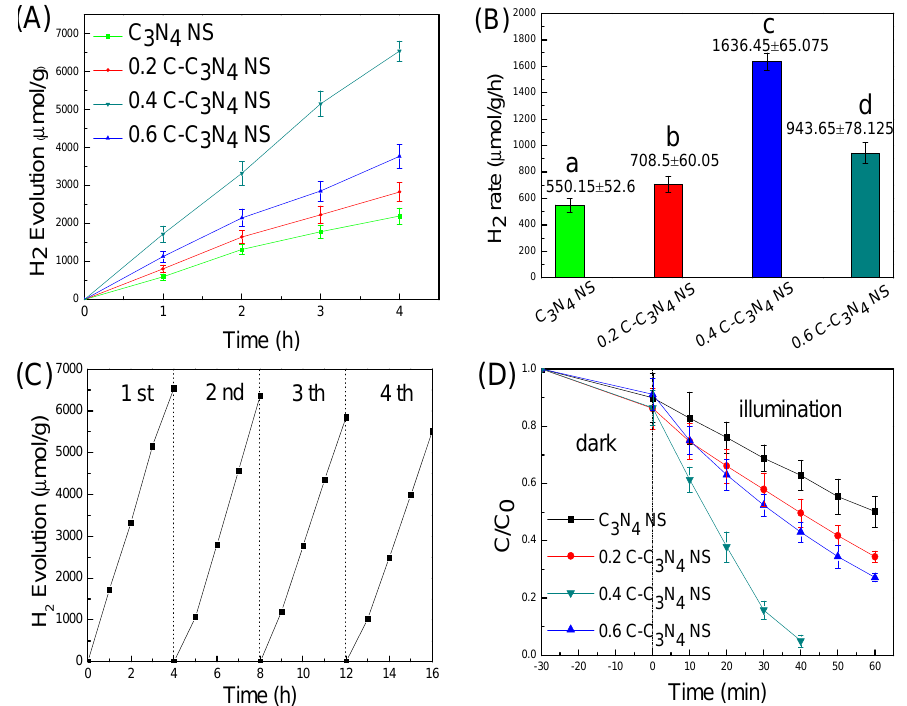
Figure 6. ( A ) Photocatalysis hydrogen evolution and ( B ) volume histogram of series of samples. ( C ) Photocatalysis hydrogen evolution stability test of 0.4 C ‐ C 3 N 4 NS. ( D ) Photocatalysis rhodamine B (RhB) degradation performances of series of samples.